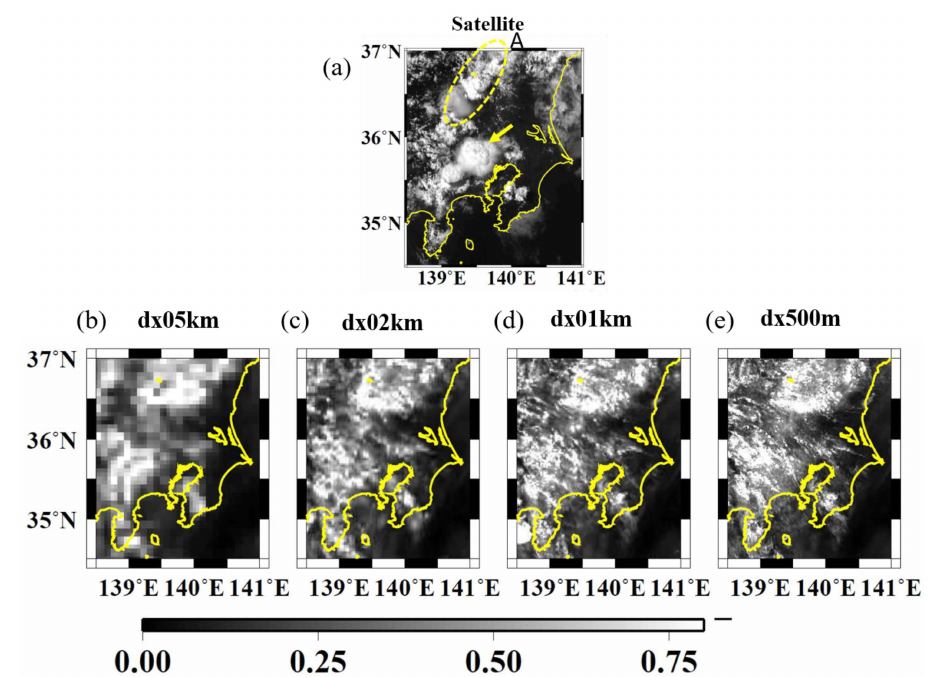
Figure 7. Comparison of the cloud horizontal distributions between the satellite observations and simulations. ( a ) Satellite visible image (Band-3) for the Tokyo electric power company (TEPCO) area at 14 JST on 30 July 2015. Cloud forecasts (5 h ahead forecasts of all cloud amounts used in radiation process) obtained from ( b ) dx05km, ( c ) 02km, ( d ) dx01km, and ( e ) dx500m with 00 UTC (09 JST) initialization time are shown, respectively. The yellow arrow in ( a ) indicates the location of the target cumulus